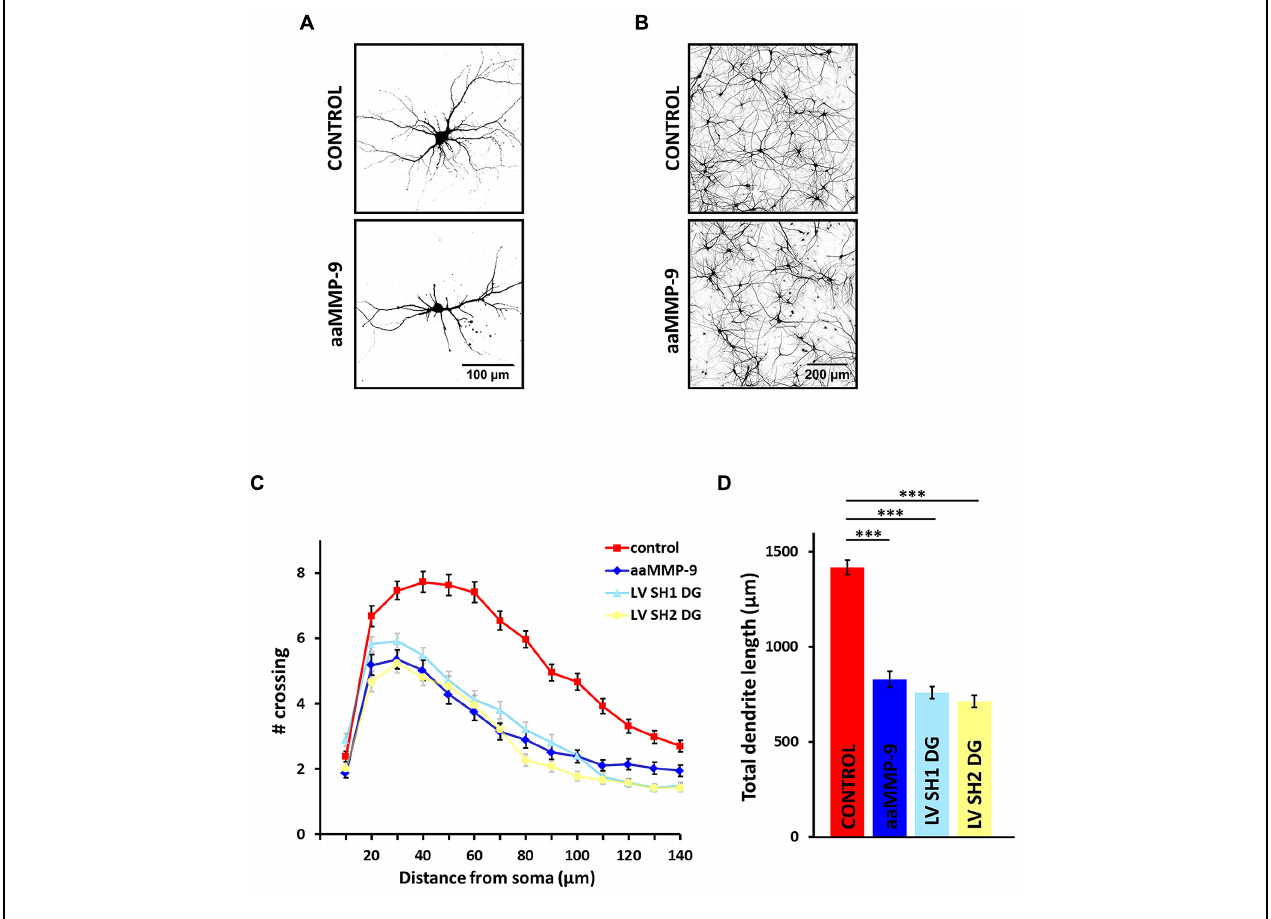
FIGURE 3 | Matrix metalloproteinase-9 (MMP-9) activity inhibits dendritic growth and arborization. (A) Representative images of hippocampal neurons from control culture and cultures treated with autoactivating MMP-9 (aaMMP-9). The cells were transfected with an RFP-coding vector to visualize the exact morphology. (B) Representative images of hippocampal cultures treated as in (A) following immunofluorescence staining with anti-MAP2 antibody. (C) Sholl analysis of hippocampal neurons exposed to aaMMP-9 ( n cell = 55) vs. control ( n cell = 36) and neurons infected